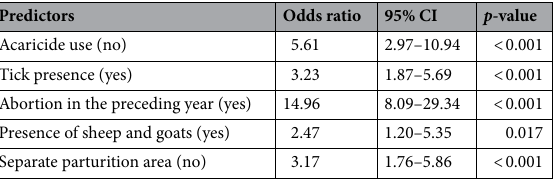
Table 5. Final multivariate model including significant predictors of Q fever seropositivity.